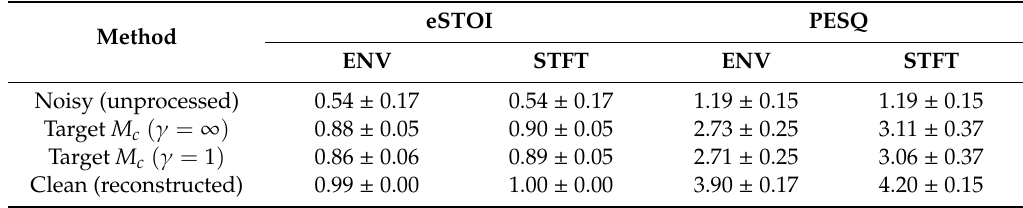
Table 1. Objective speech intelligibility (eSTOI) and quality (PESQ) results between the standard STFT and the proposed ENV analysis-synthesis frameworks. Mean and standard deviation values are presented for the first 100 utterances of the TIMIT test